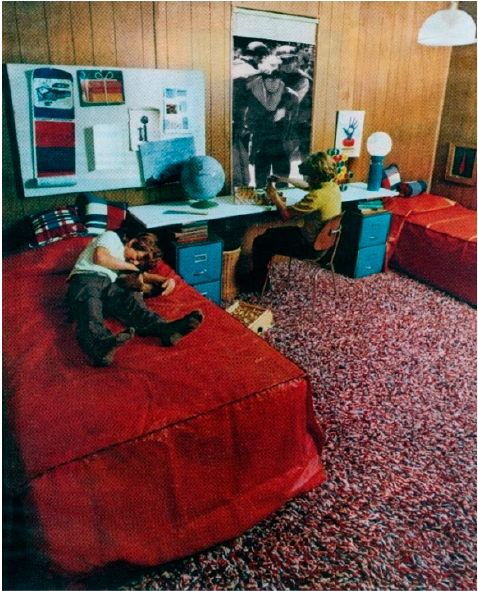
Figure 2. Martha Rosler, Boys Room , from the series House Beautiful: Bringing the War Home , c. 1967– 1972. Photomontage. © Martha Rosler/Courtesy of the artist and Mitchell ‐ Innes & Nash, New York.